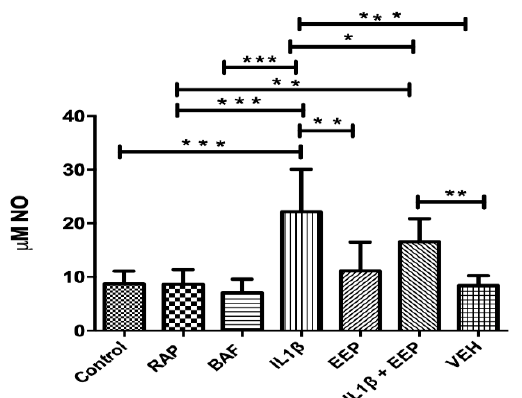
Figure 6. Analysis of nitric oxide in samples of rabbit chondrocytes stimulated with IL-1 β and treated with EEP for 24 h. Different letters indicate statistic differences significance. Control: No treatment, Control RAP: treated with rapamycin 100 nM (positive control autophagy), Control BAF: treated with bafilomycin 20 nM (negative control autophagy), IL-1 β : treated with IL-1 β 10 ng/mL, EEP: treated with EEP 2.5 µg/mL, IL-1 β EEP: treated with IL-1 β and EEP and vehicle: treated with ethanol. * p < 0.05, ** p < 0.005, *** p < 0.001. One-way ANOVA, Tukey Multiple Comparison Test. ( N = 5